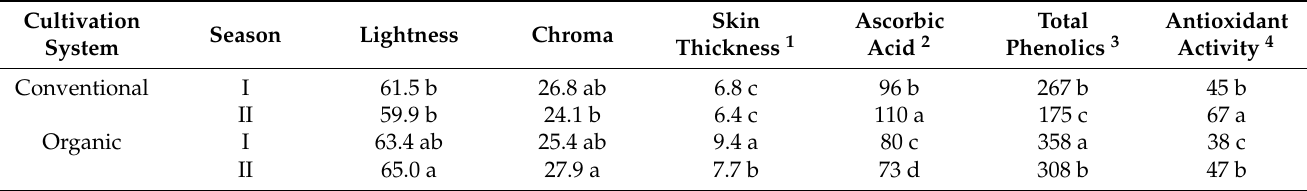
Table 6. Physico-chemical and nutritional quality of early potatoes as affected by ‘cultivation system × season’